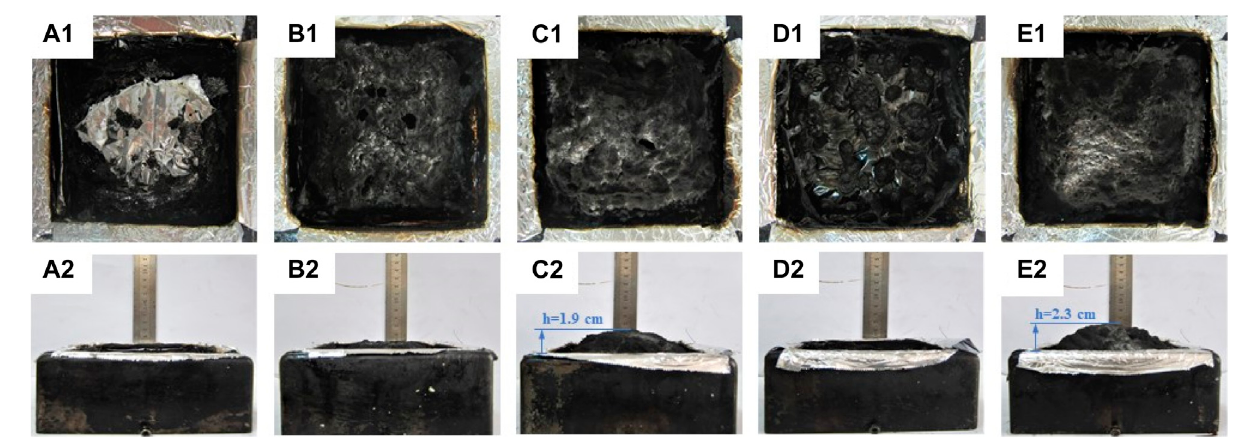
FIGURE 6 | Residual char digital photos of Pure RPUF (A) , RPUF/APP-30 (B) , RPUF/MAPP-30 (C) , RPUF/APP-1000 (D) and RPUF/MAPP-1000 (E) .